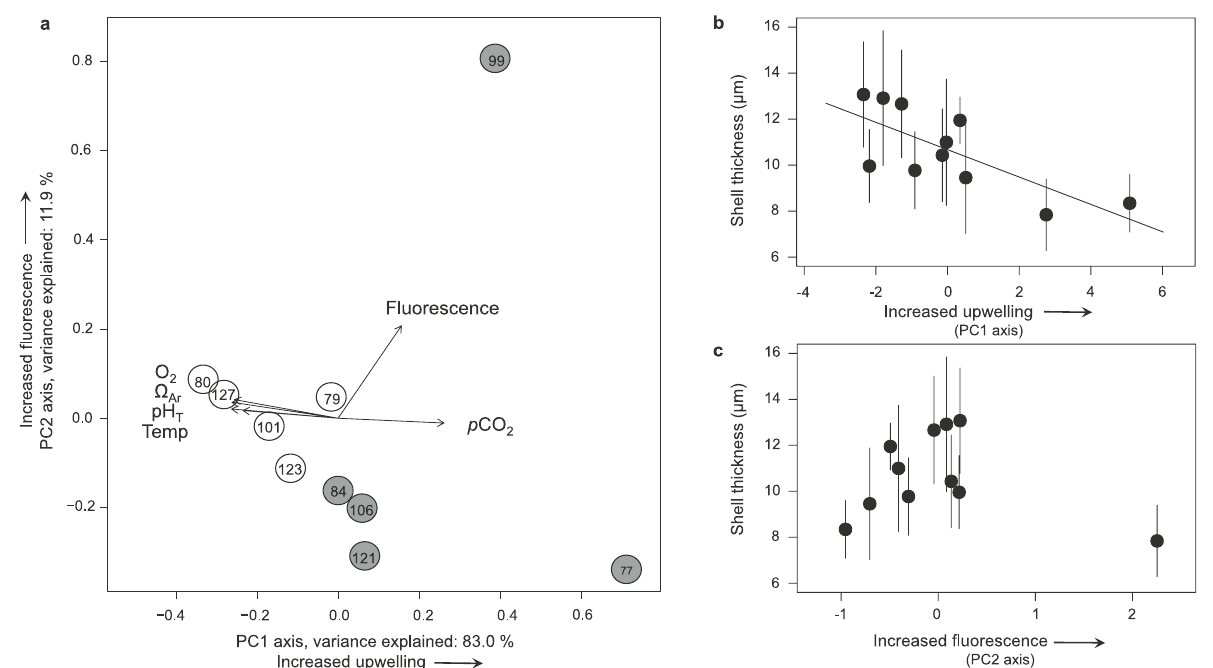
Figure 2. Relationships among ocean variables and average shell thickness of L. helicina pteropods. ( a ) Principal Component Analysis (PCA) based on aragonite saturation (Ω Ar ), p CO 2 , pH, temperature (Temp), oxygen (O 2 ) and chlorophyll fluorescence. The numbers within the plot represent the sampling stations used for analyses. Circles indicate stations with strong upwelling conditions nearshore (grey), and with less intense upwelling conditions offshore (white), see also Fig. 1. PC1 explains 83.0% of the variation among stations, and essentially reflects the offshore-onshore gradient driven by coastal upwelling. PC2 explains 11.9% of the variation, and is largely driven by variation in chlorophyll fluorescence. ( b ) Average shell thickness decreased significantly with PC1, associated with the upwelling gradient (principal component regression: y = − 0.595 PC1 + 10.671; R 2 = 0.487, N = 11, p = 0.010). ( c ) Average shell thickness did not vary significantly with PC2, associated with chlorophyll fluorescence (principal component regression: R 2 = − 0.058, N = 11, p = 0.519). Each dot in ( b , c ) represents the mean ± SD of average shell thickness calculated over all 6–8 individuals per station. PC axes in the biplot ( a ) were scaled according to Gabriel (1971), whereas PC axes in ( b , c ) are